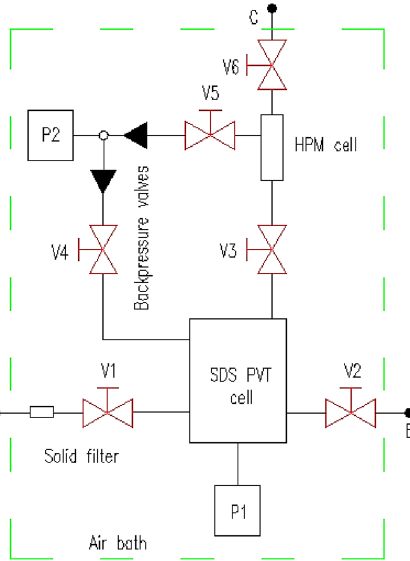
Fig. 1 Schematic diagram of the PVT unit. (P)—pump, (V)—valve, (A, B, C)—connection points of the external equipment